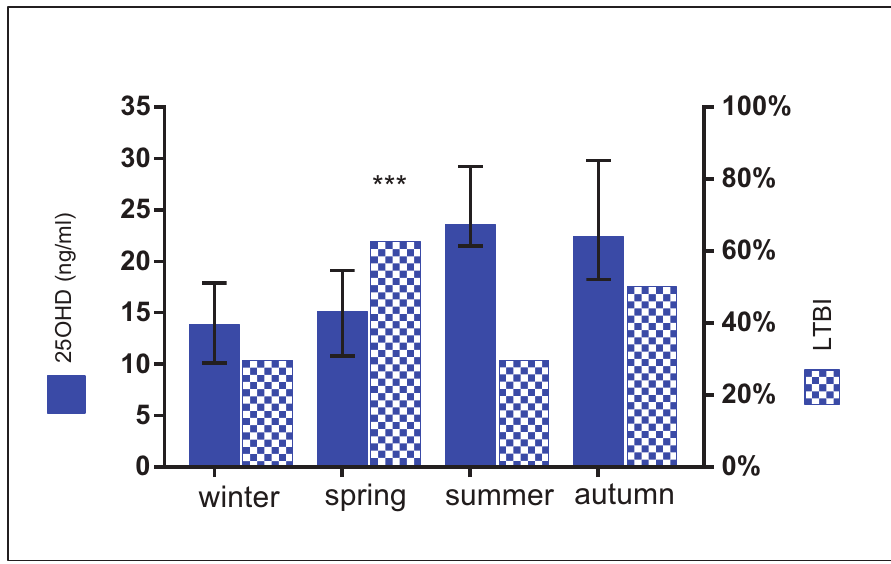
Fig 2. Plasma levels of 25OHD in household contacts (HHC) (n = 139) and proportion of HHC with latent TB infection (LTBI) in each season. Medianvalue with IQR is shown. The proportionof LTBI found in HHC was higherin spring (62.5%) than in other seasons(32.7%). ( *** p =